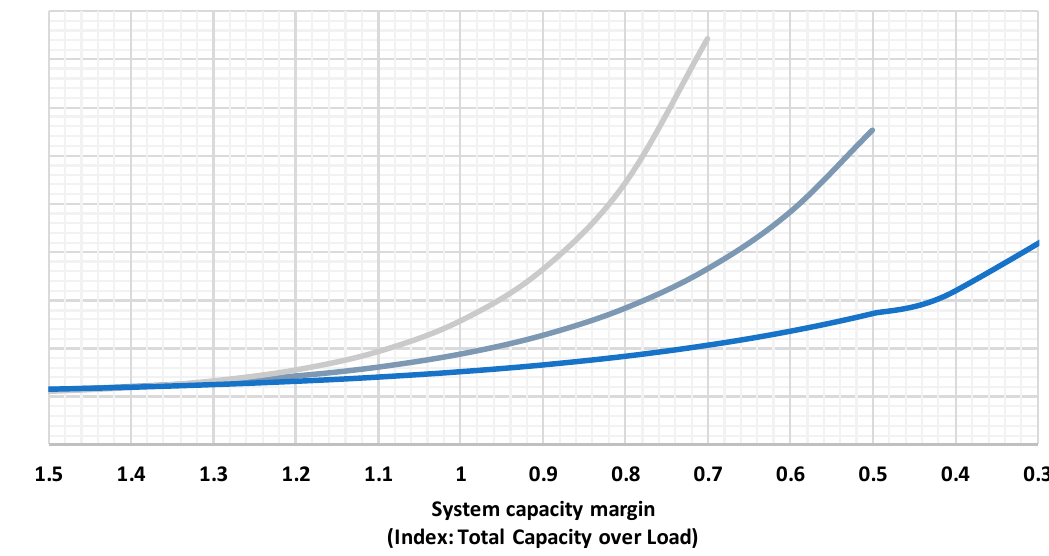
Figure 2. Example of endogenous scarcity bidding depending on systems’ capacity margin.